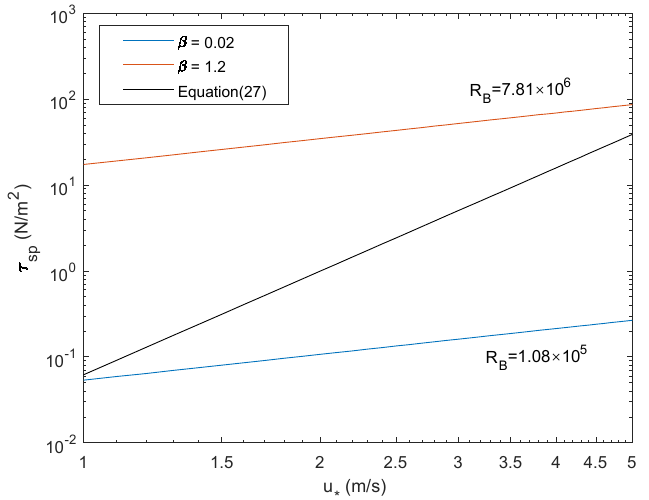
Figure 5. Comparison of the sea spray momentum flux and the result from Equation (27) under different wave ages.